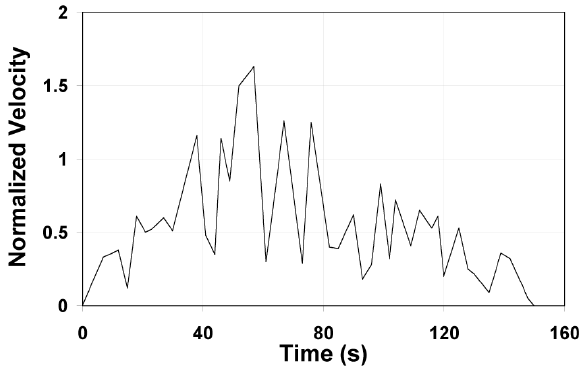
Fig. 3. Normalized tangential velocity in TS event